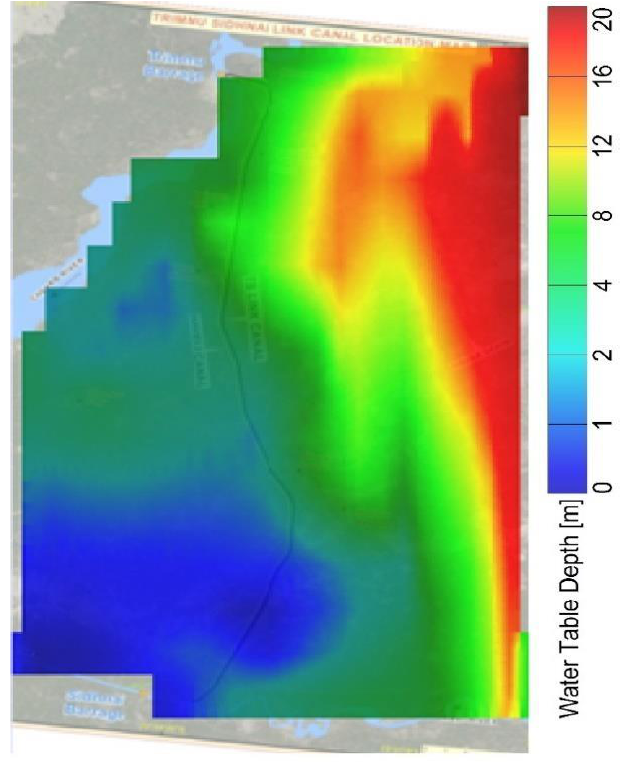
Figure 7. Simulated Depth to Water Table in the Study Area.